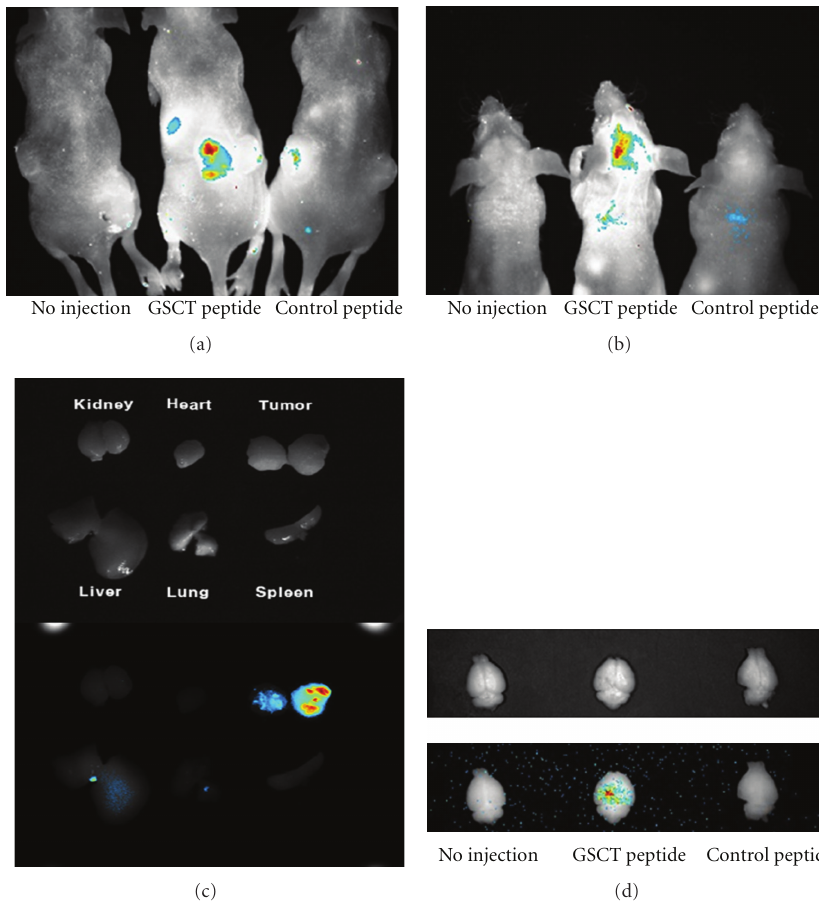
Figure 3: Homing of GSCT peptide to GSC-derived tumors in vivo [27]. (a) In vivo biodistribution of GSCT peptide was examined by intravenous injection of Q-dot 800-conjugated GSCT (QGSCT) or control peptide in mice bearing subcutaneous tumors derived from the injection of Id4-driven mouse GSCs. Whole-body biofluorescence images were obtained 24 h after injection of Q-GSCT and Q-control peptides. (b) In vivo biodistribution of Q-Dot 800-conjugated GSCT or control peptide in orthotopic brain tumor models. Whole-body biofluorescence images were obtained 4 days after injection of Q-GSCT and Q-control peptides in mice bearing orthotopic brain tumors derived from the injection of Id4-driven mouse GSCs. (c) Fluorescence images of Q-GSCT peptides in tumors and organs extracted from mice bearing subcutaneous tumors are shown in Figure 3(a). (d) Fluorescence images of Q-GSCT peptides in brains extracted from mice bearing orthotopic tumors are shown in Figure 3(b). With reprint permission from